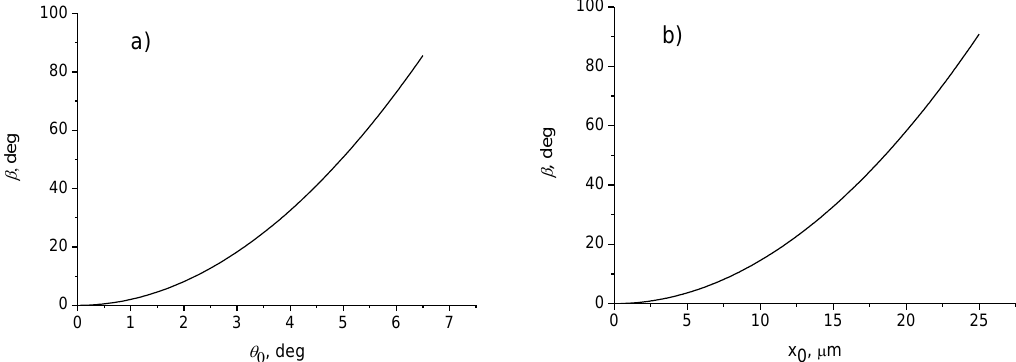
Figure 5. The dependence of the angle of rotation of the polarization plane on ( a ) tilt angle θ 0 of the beam relative to the fiber axis; ( b ) offset x 0 in a graded-index optical fiber with the parameters ω = 7 · 10 − 3 µ m − 1 , n 0 = 1.5, and the length z = 5 cm.